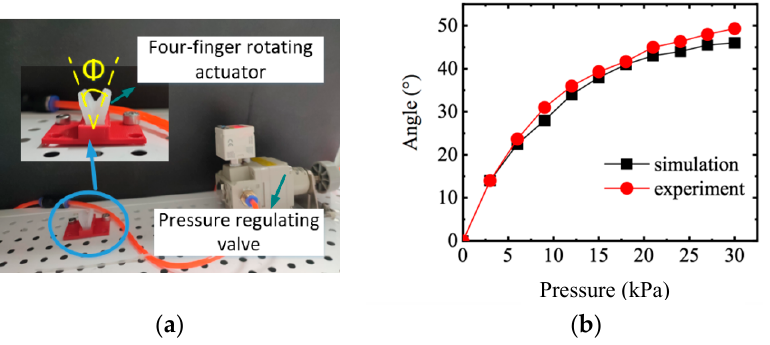
Figure 15. Angle test of rotating actuator. ( a ) Angle test. ( b ) Angle of rotating actuator.